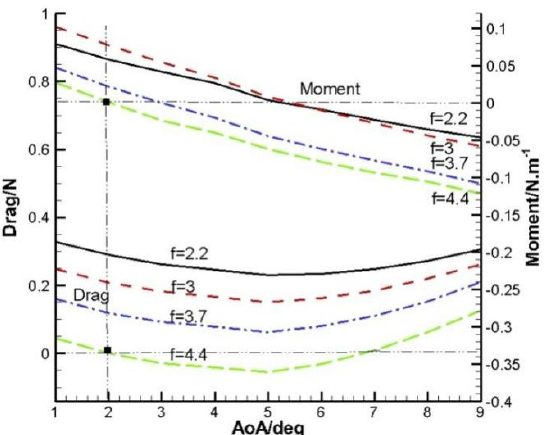
Figure 8. Trim process through adjusting the angle of attack and flapping frequency while keeping the wash-out angle at − 13 degrees.